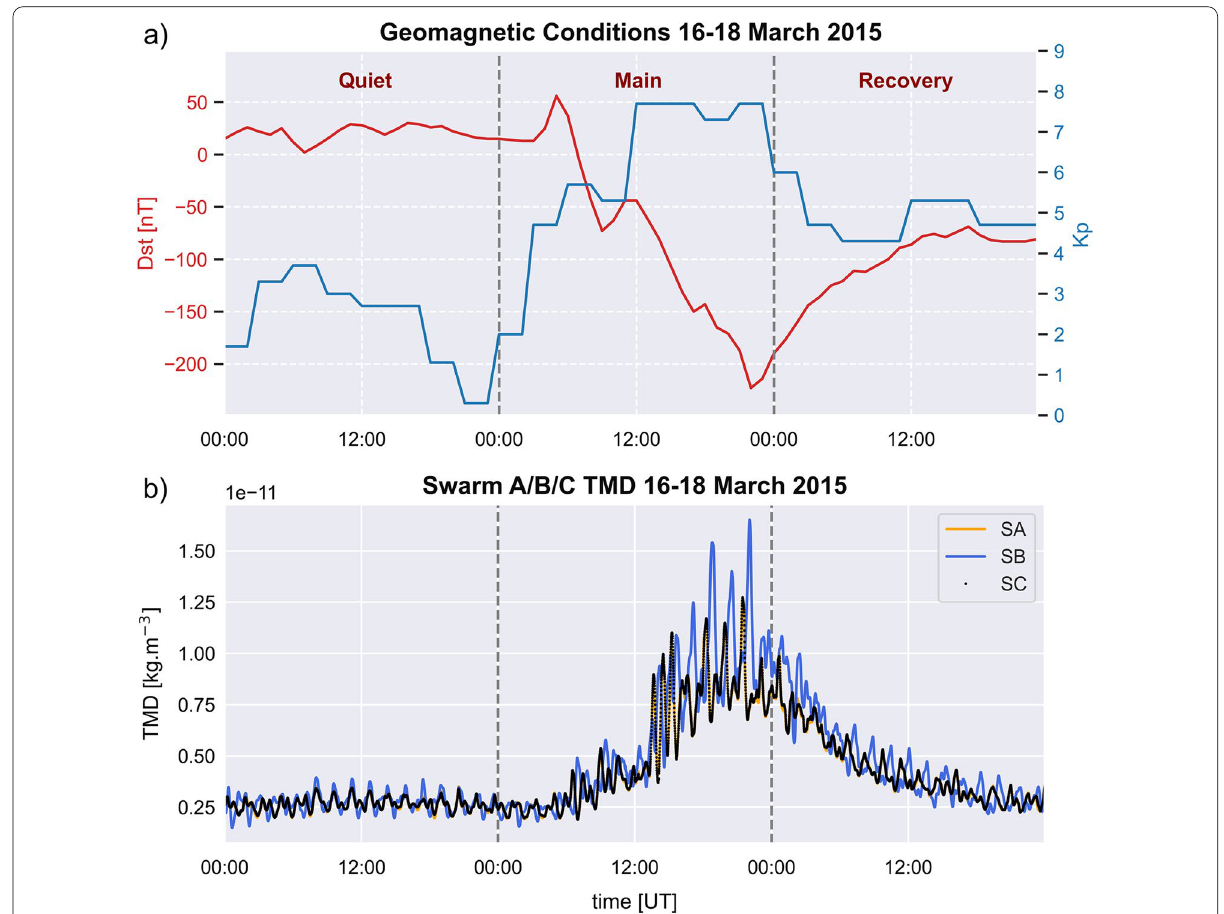
Fig. 1 St. Patrick’s Day storm 2015. a geomagnetic activity represented by the Dst (red) and 3‑h average Kp (blue) indices. b Along the orbit thermospheric mass density observations from Swarm‑A, ‑B, and ‑C satellites (yellow, blue, and black) normalized to 400 km altitude. The period from 16 to 18 March 2015 includes a pre‑storm quiet day, the main phase of the storm and the first day of the recovery phase. A strong perturbation in geomagnetic activity and neutral density is visible during the main phase of the